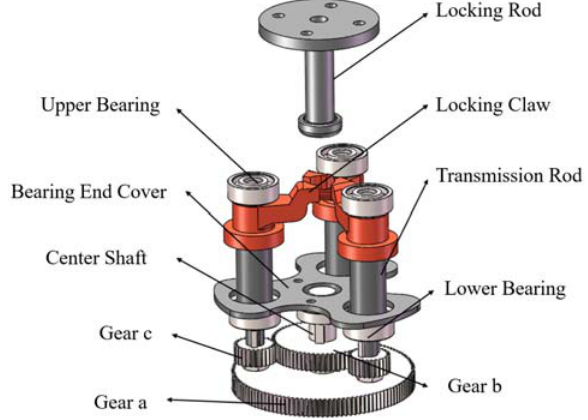
Figure 3. Internal structure of the locking assembly.